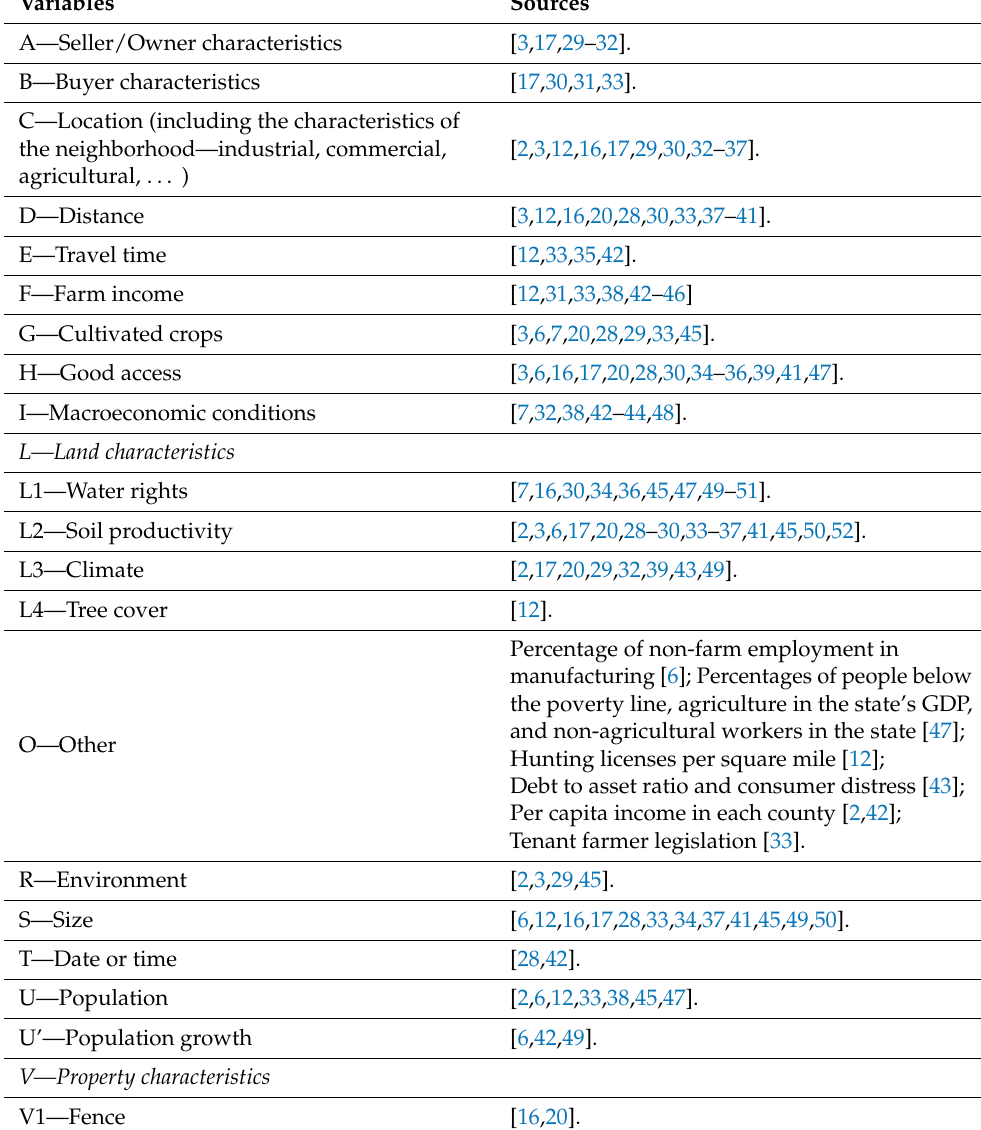
Table 1. Factors that impact farmland value and supporting